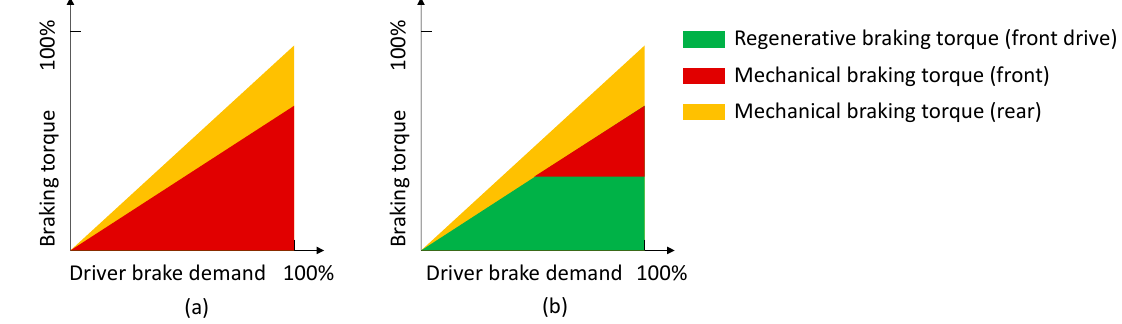
Figure 3. Brake-blending criteria: typical braking repartition in absence of regenerative braking capabilities ( a ) and brake blending for vehicles capable of regenerative braking capabilities on front axle ( b ).